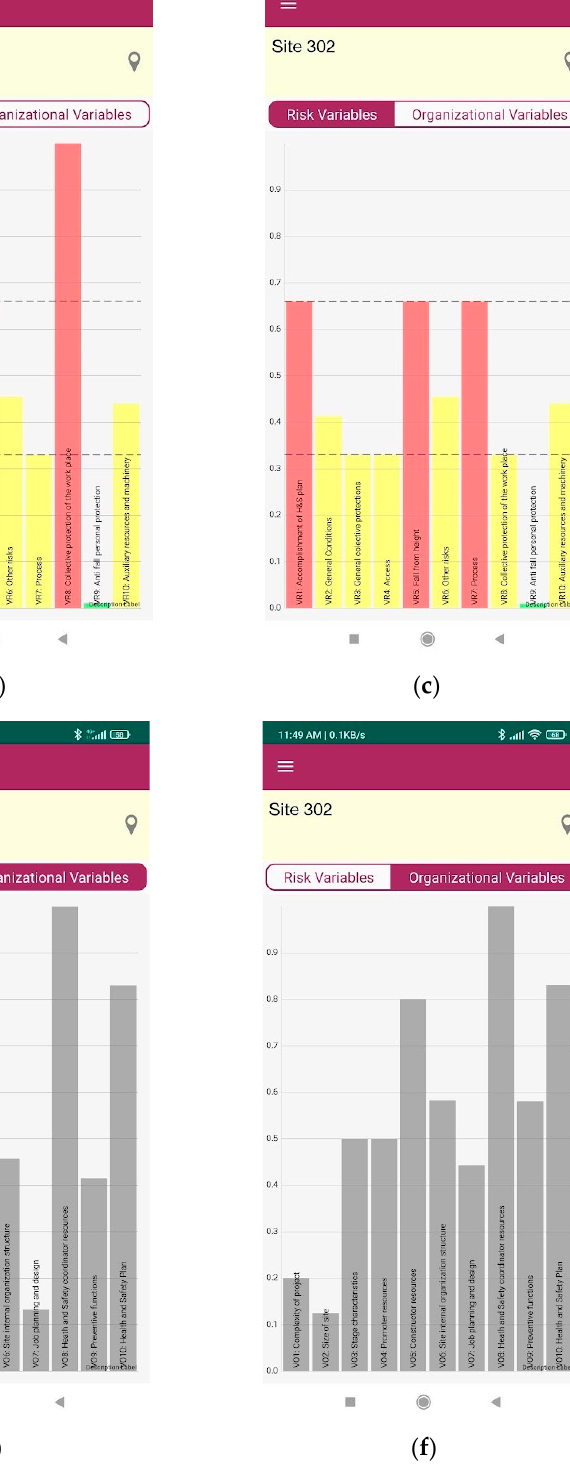
Figure 3. Examples of graphs representing the measurement levels for the risk ( a – c ) and organiza- tional variables ( d – f ). From left to right: site 223, site 938, and site 302. Source: App screenshots.